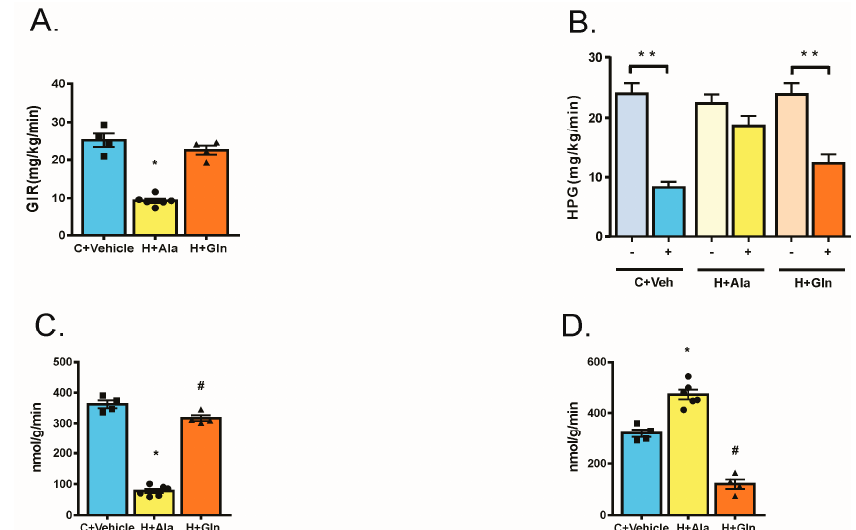
Figure 3. Steady-state glucose infusion rates (GIR) obtained from averaged rates of 90 to 120 minutes of 10% unlabeled glucose infusion ( A ), insulin-induced suppression of hepatic glucose production (HGP) ( B ), insulin-stimulated muscle glucose uptake ( C ), and insulin-stimulated adipose glucose uptake ( D ). Rats that received the chow diet and vehicle (C+Veh, n = 4), rats fed with a high-fat diet and supplemented with Alanina (H+Ala, n = 6) and rats fed with a high-fat diet supplemented with glutamine (H+Gln, n = 4). Values were displayed as mean ± SEM. One-Way-ANOVA with the Bonferroni post-test was used in A to D. * p < 0.05 vs C+Veh and H+Ala; ** p < 0.05 vs same group without insulin stimulation; # p < 0.05 vs C+Veh.